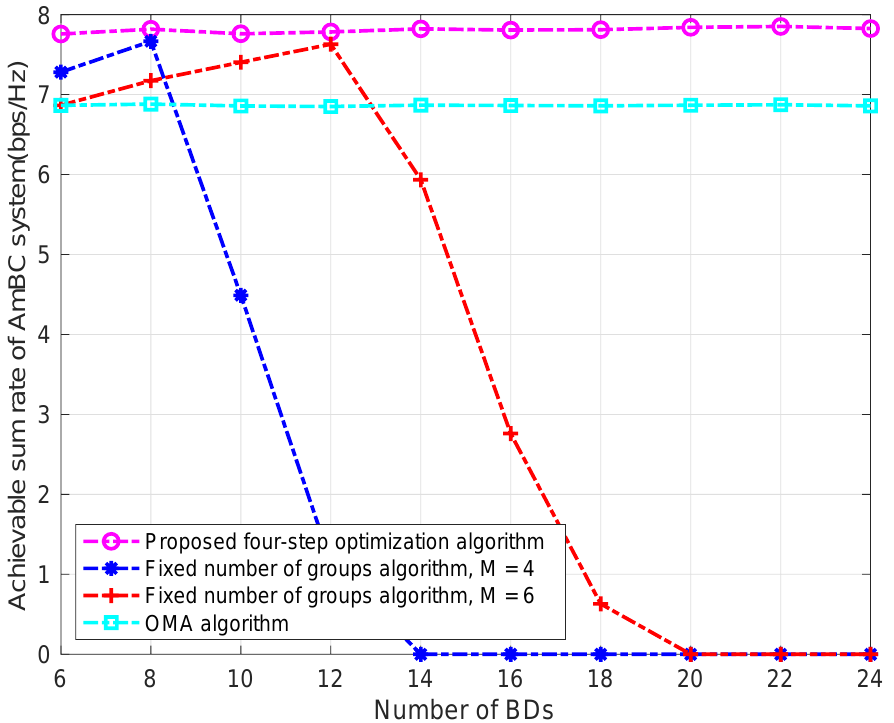
Figure 6. ASR vs. number of BDs.